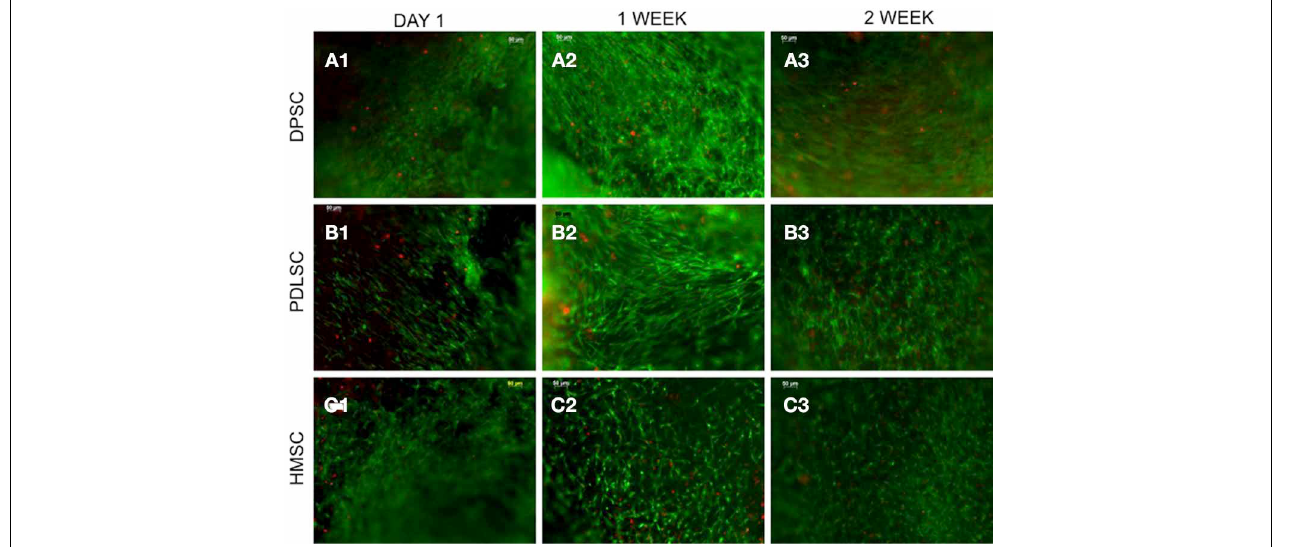
FIGURE 1 | Live-dead cell assay. The fluorescent micrographs are representative images of DPSCs (A) , PDLSCs (B) , and HMSCs (C) within the pulp ECM scaffolds imaged after 24h (A1–C1) , 1 week (A2–C2) , and 2 weeks (A3–C3) post seeding. The green